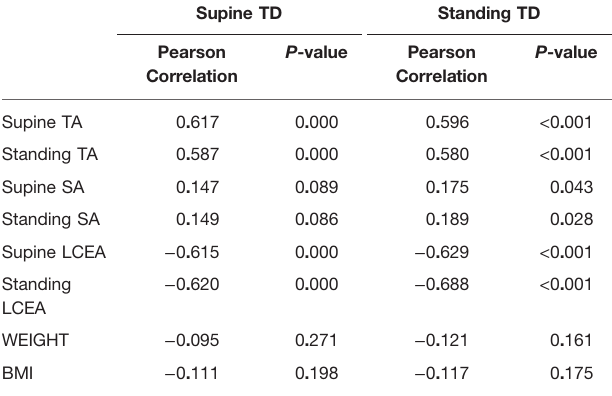
TABLE 2 | Correlation between TD and other hip parameters.